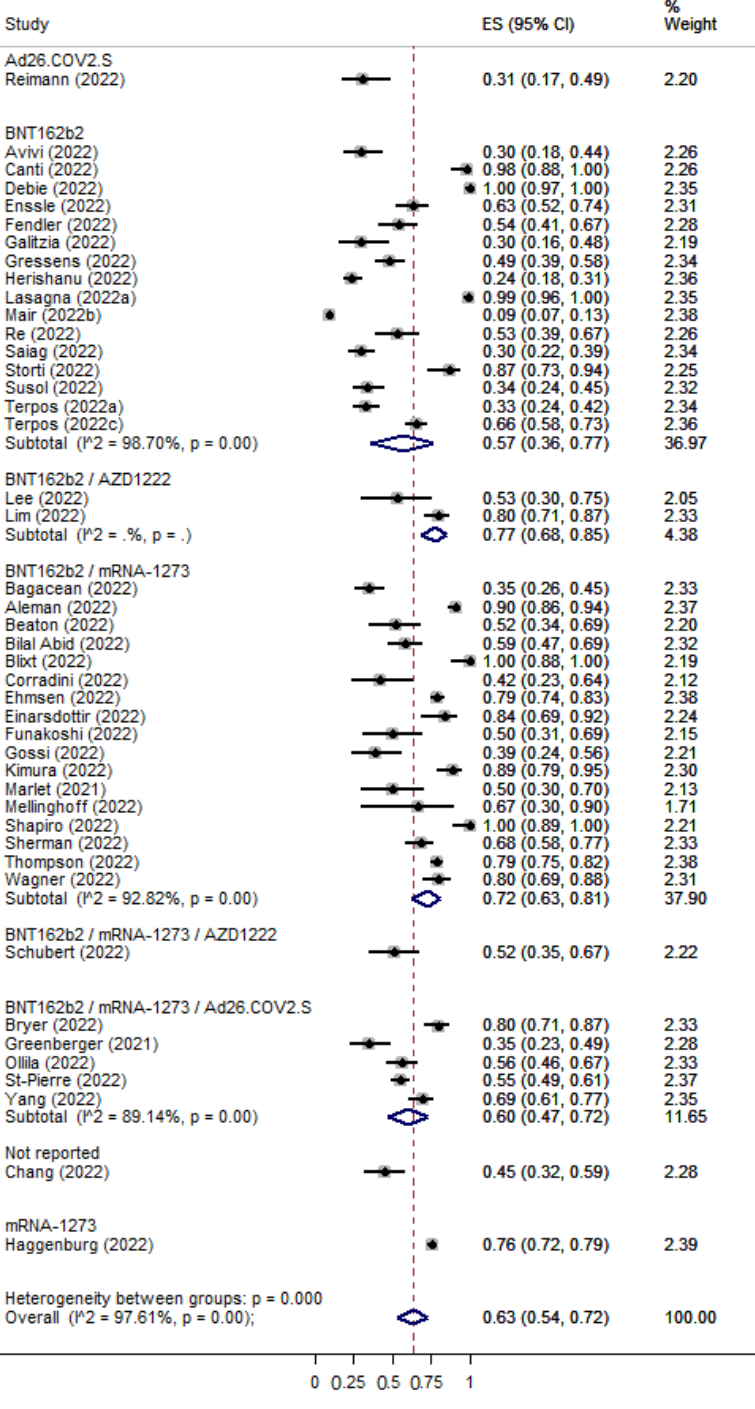
Figure 6. Pooled EffectSize (ES) for the immune seroconversion rates of patients with hematological malignancies after the third dose of COVID-19 vaccine